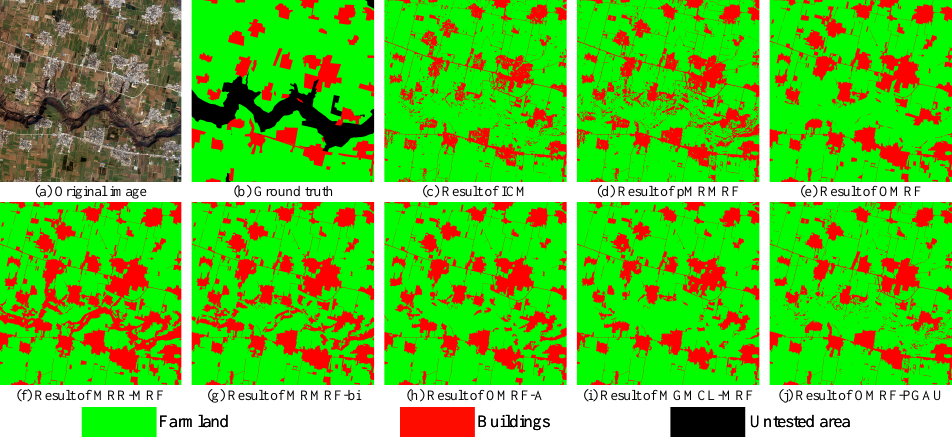
Figure 13. Semantic segmentation results for medium size Gaofen-2 image.